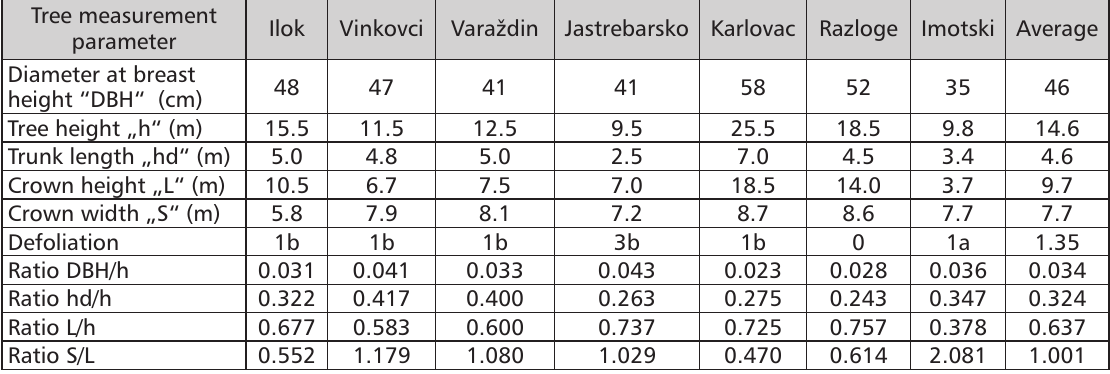
The selected Horse chestnut tree measurement